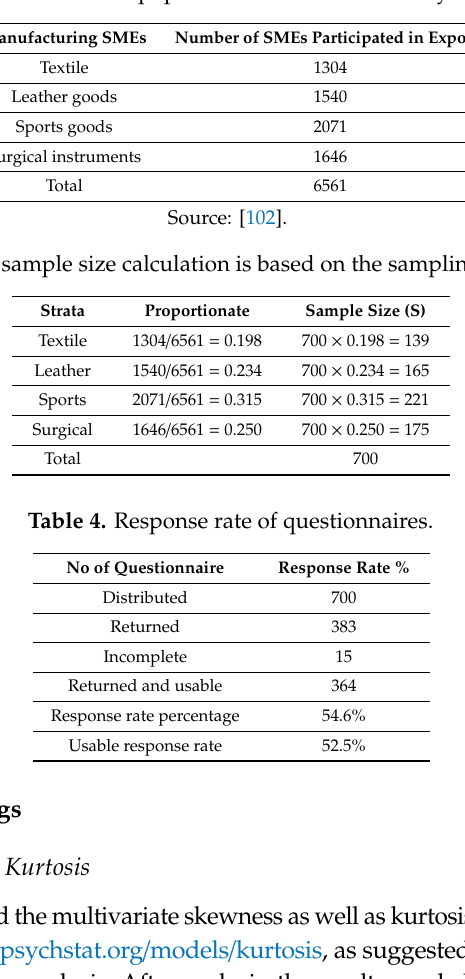
Table 2. The population of the current study.